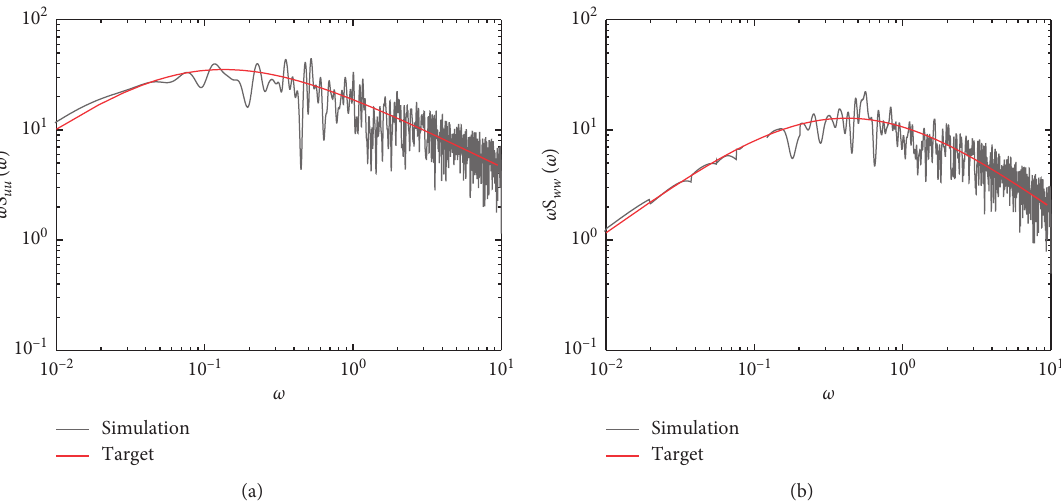
Figure 10: Comparisons between simulated spectra and target ones at the midspan (#15) of Case 1: (a) longitudinal component; (b) vertical component. AoA � 0 ° .